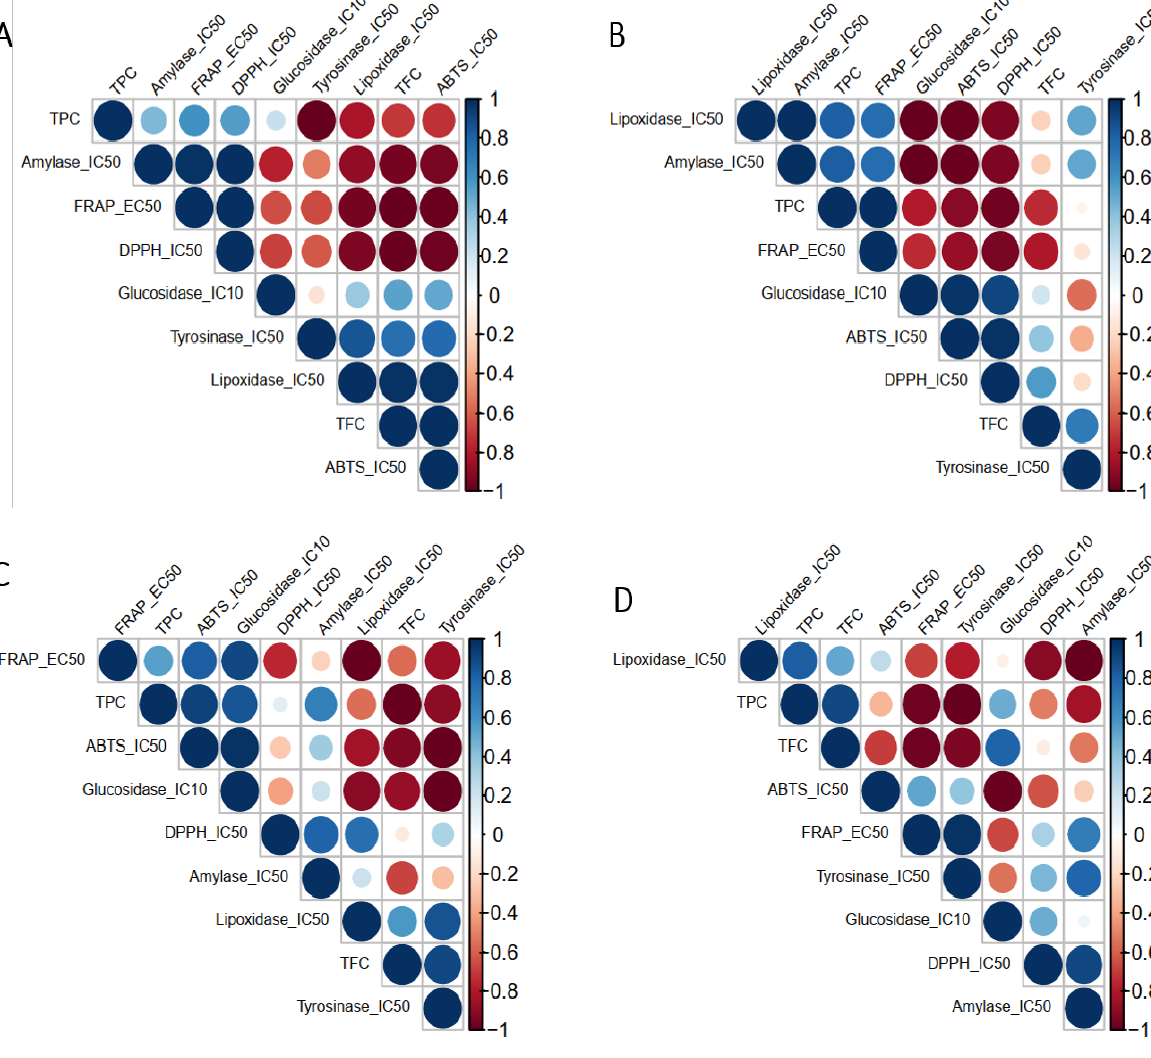
Figure 5. Correlations among chemical activities (antioxidative, anti-inflammatory, antidiabetic, and anti-tyrosinase) within each J. regia extract ( A ) Methanolic Extract of bark, ( B ) Methanolic extract of Husk, ( C ) Methanolic Extract of Kernels, and ( D ) Methanolic Extract of Leaves. As for the anti-inflammatory properties, the anti-LOX activity was correlated with the TFC and the antioxidant activity in MWB, MWH, and MWK, contrary to MWL, the anti-LOX activity was correlated with TPC and TFC. The anti-tyrosinase activity of MWK and MWL was correlated positively with TFC and FRAP, respectively. When we used a heatmap coupled with a dendrogram to highlight the relationships among different chemical screening within each extract, we found out that for the MWB extract (Figure 6), the chemical screenings are clustered into two distinct groups: (i) the first group contained FRAP, TPC, amylase et lipoxidase and (ii) the second group harbored tyrosinase, TFC, glycosidase, DPPH, and ATBS. Similarly, for the MWK (Figure 7) extract, the heatmap showed two groups: (i) the first one included TFC, ABTS, lipoxidase, tyrosinase, and glycosidase; (ii) the second one contained TPC, DPPH, FRAP, and amylase.